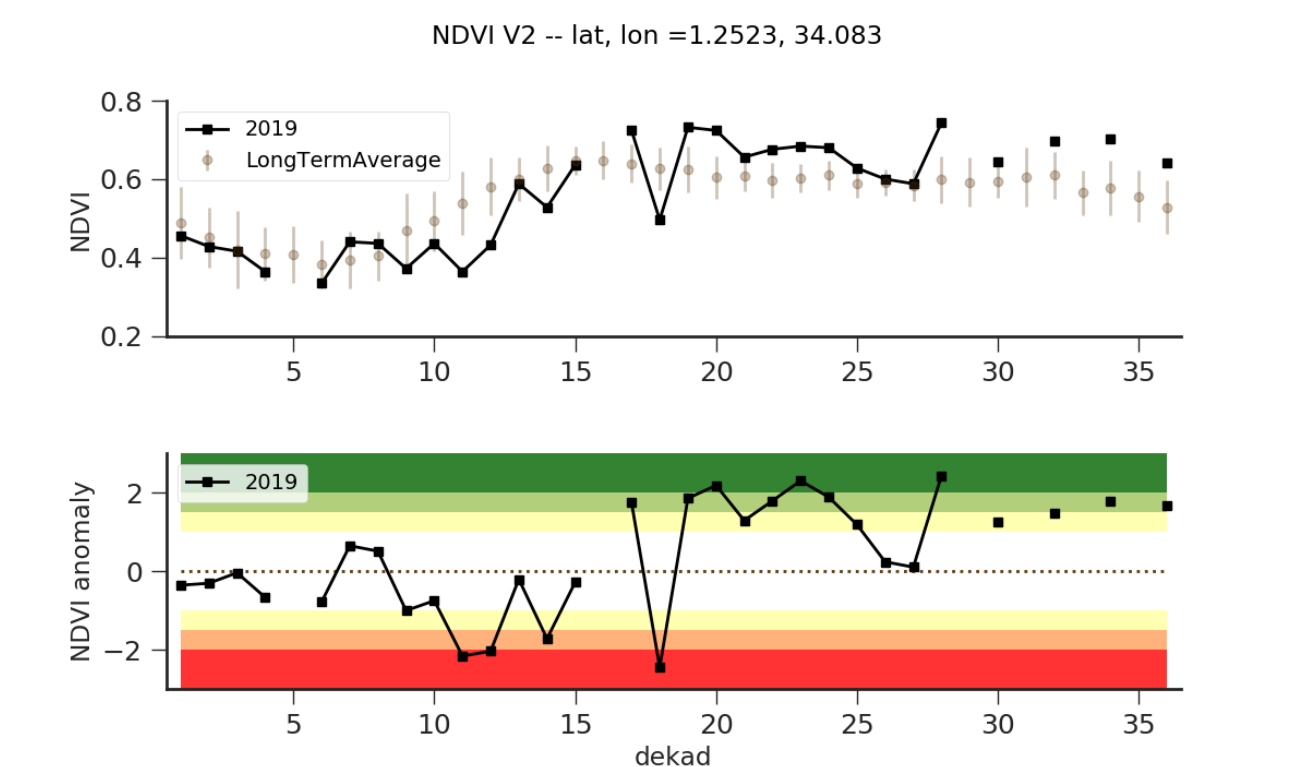
Figure 3. Time series of NDVI (top panel) and NDVI anomalies (bottom panel) for a pixel near Bukedea (lat = 1.25 ◦ , lon = 34.08 ◦ ), Uganda. Data is extracted from the CGLS Collection 1km NDVI Version 2 product. The NDVI temporal evolution for 2019 and long-term (1998–2020) average NDVI profile are shown in the top panel. NDVI anomalies over 2019 are computed via a z-score. Positive (negative) anomalies denote whether an NDVI values is above (below) the long-term NDVI average. The absolute value of the NDVI anomaly indicates how many standard deviations the NDVI value departs from the long-term NDVI average. Colored bands in the bottom panel denote vegetation growth status and are defined as follows: normal([ − 1, 1]; white), warning ([ ± 1, ± 1.5]; yellow), favorable ([1.5, 2]; light green), unfavorable ([ − 1.5, − 2]; light red), very favorable ( > 2; dark green) and very unfavorable ( − 2 < ; dark red). Gaps in Time-Series occur due to the lack of clear data for that